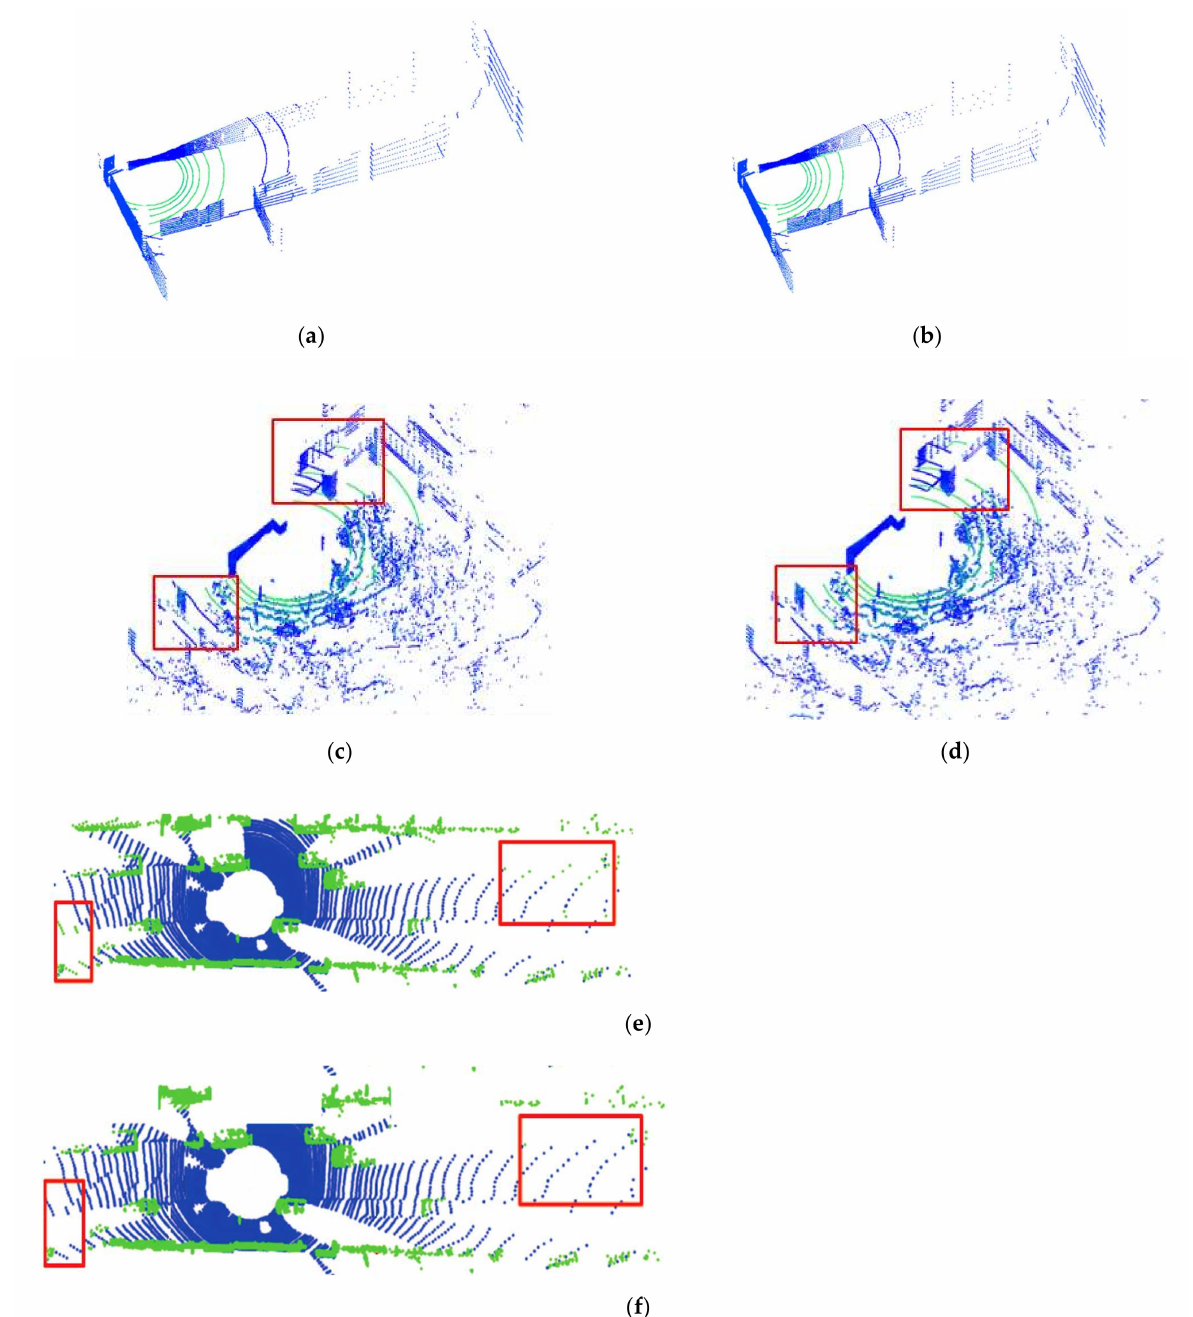
Figure 5. Ground segmentation results of different scenes. The green points are the ground points extracted by the RANSAC algorithm in ( a , c , e ); the green points are the ground points extracted by the improved RANSAC algorithm in ( b , d , f